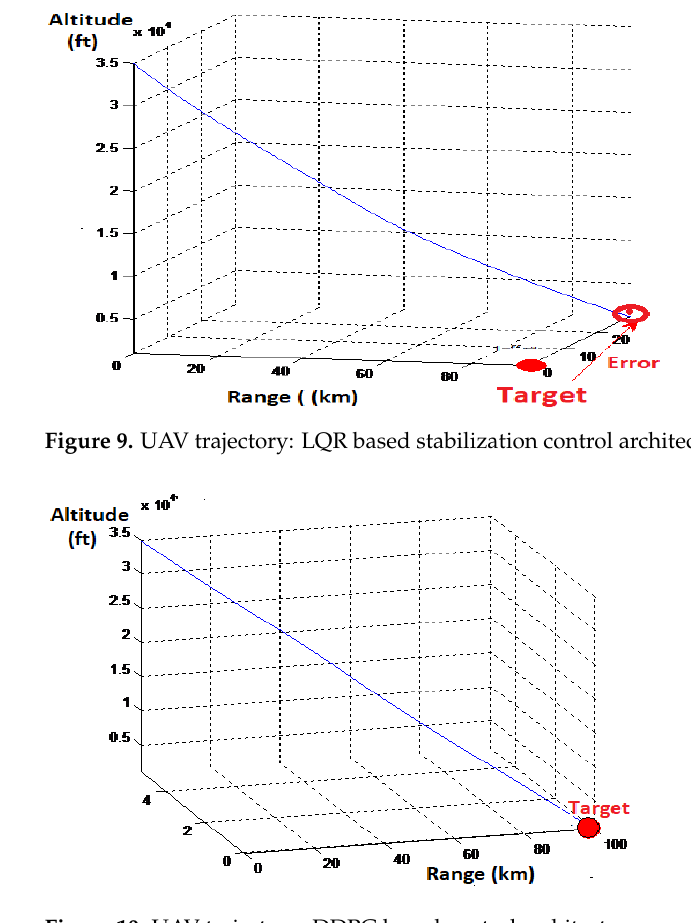
Figure 10. UAV trajectory: DDPG based control